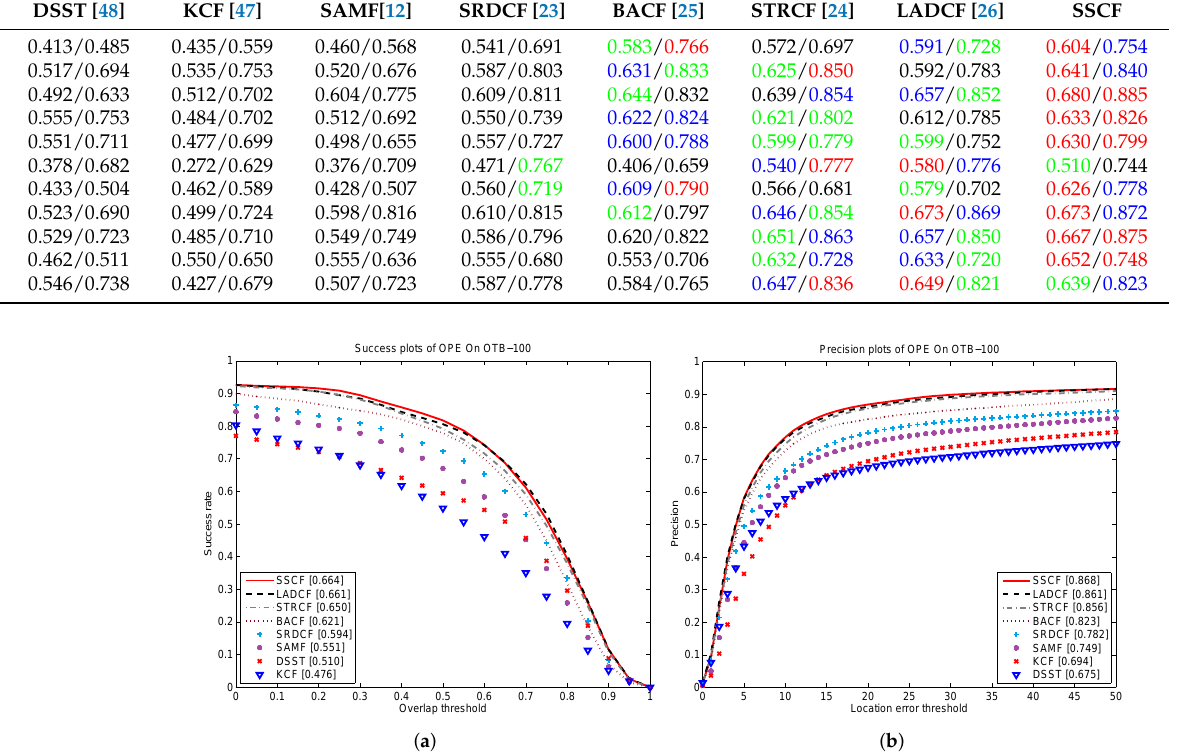
Table 1. The area under the curve (AUC) and distance precision (DP) scores of the proposed SSCF and the other trackers on different attributes on the CVPR2013 database. The top-three methods on each attribute are denoted by different colors: red, blue, and green. That is, red represents the best performance, blue represents the second best, and green represents the third best (AUC/DP).